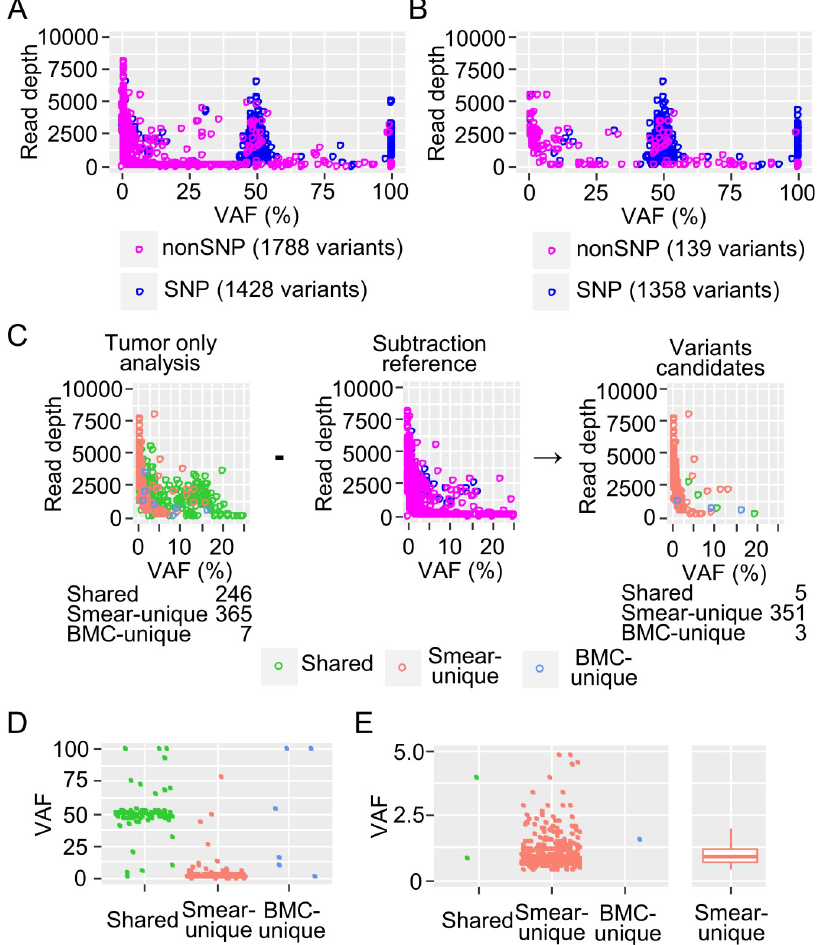
Fig 5. Panel of Normals (PON) subtraction method and evaluation. Distribution of all the variants (A) and the filtered variants (B) detected by PON. Variants with SNP and the other variants were color-coded. (C) Distribution of the subtracted variants with a low VAF. (D) VAF plot of shared, smear-unique, and BMC-unique variants after subtraction. (E) VAF plot of subtracted variants with VAF < 5%. A boxplot of smear-unique variants is also shown.